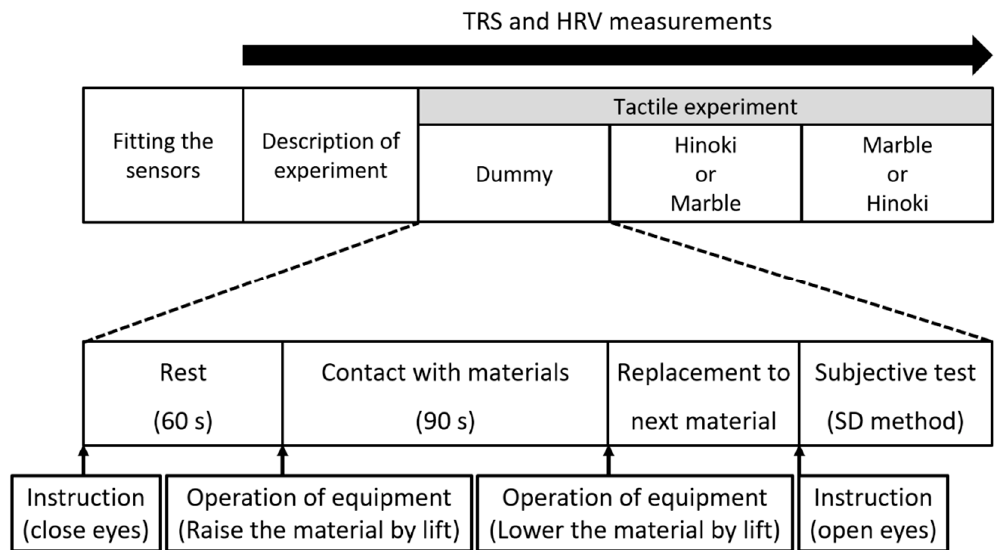
Figure 2. Procedure of the entire experiment. TRS, near-infrared time-resolved spectroscopy, HRV, heart rate variability, and SD, semantic differential.